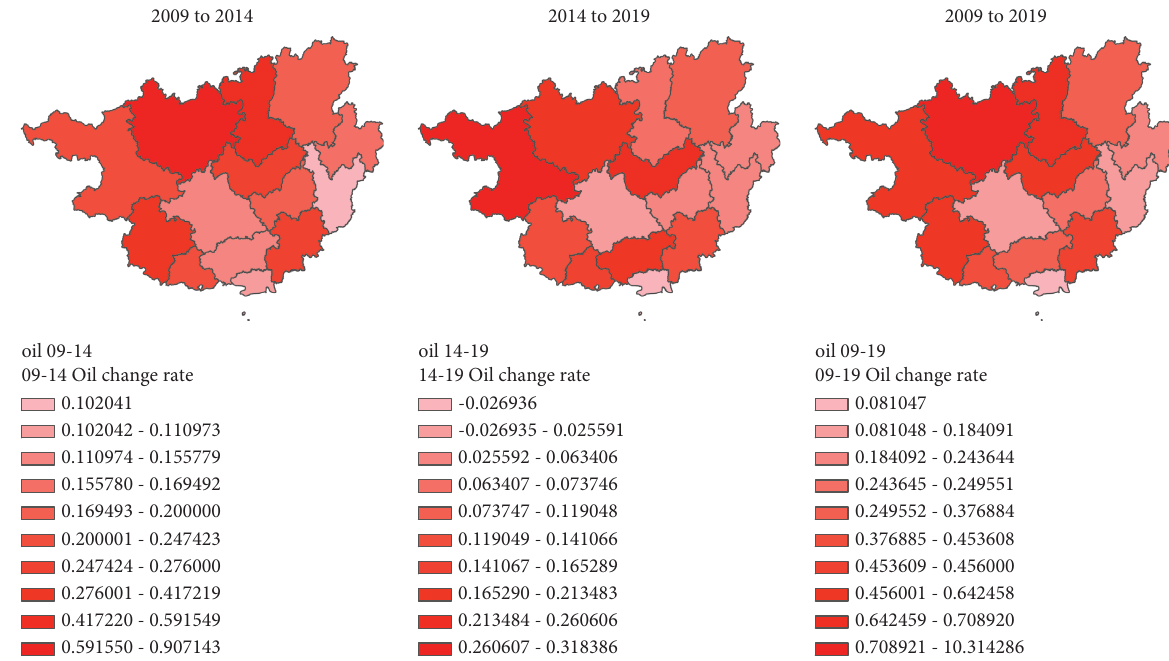
Figure 6: Change rate map of the proportion of oil crop planting area in Guangxi from 2009 to